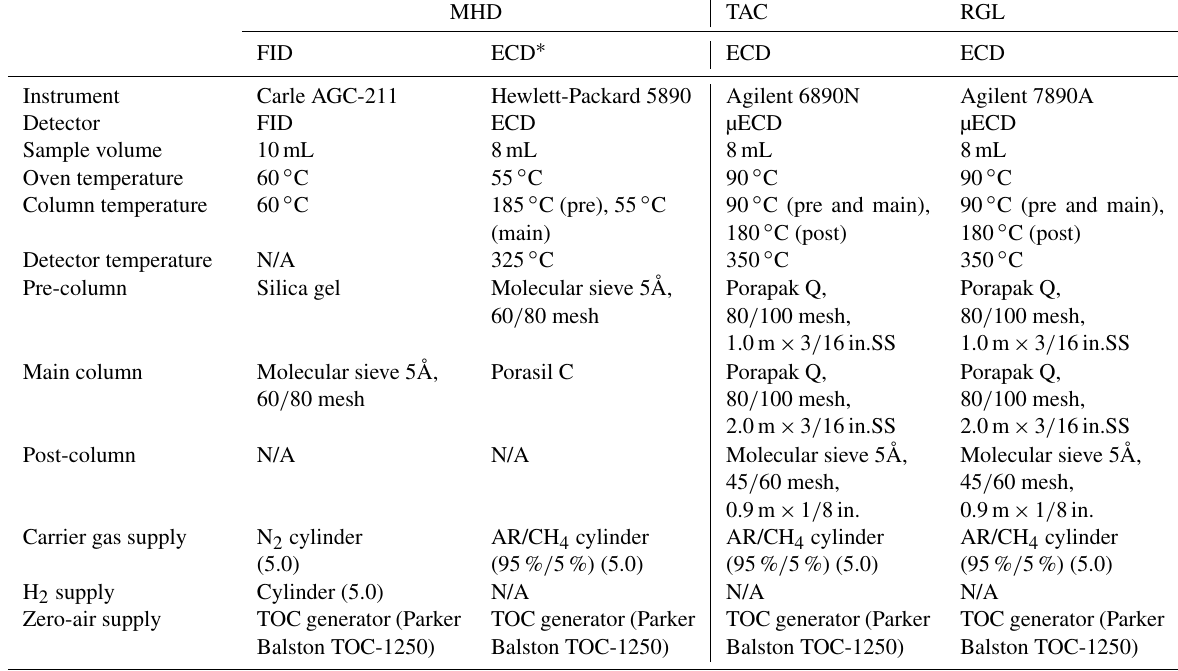
Table 3. Gas chromatograph–flame ionisation and electron capture detector equipment and setup at UK DECC stations.